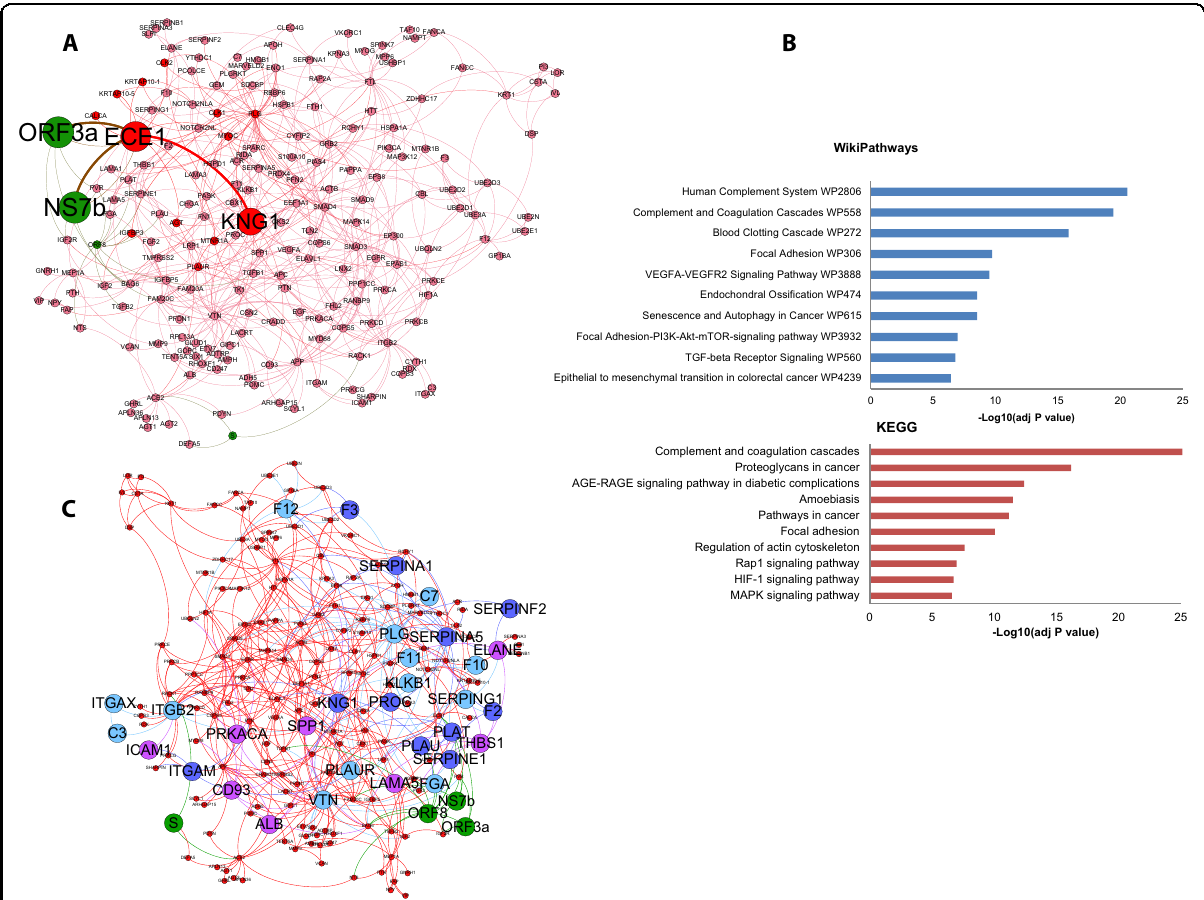
Fig. 4 PPI interactome based on human PPI and SARS-CoV-2-host interactions, with top 200 closest proteins identi fi ed by RWR, using Kininogen-1 as seed. A PPI Intercatome, where larger nodes and edges in red represent interactions via NS7b and ORF3a-ECE1-KNG1 (BK). The nodes in red are human proteins, while the nodes in green are virus proteins. B KEGG human pathway and WikiPathways Gene Enrichment analyses for 200 proteins closest to KNG-1. C PPI interactome, where proteins belonged to Human Complement System WP2806 (modes in purple) and, Complement and coagulation cascades (nodes in blue) pathways were highlighted. The proteins that belonged to both pathways were marked in light blue. The nodes in red are human proteins, while the nodes in green are virus